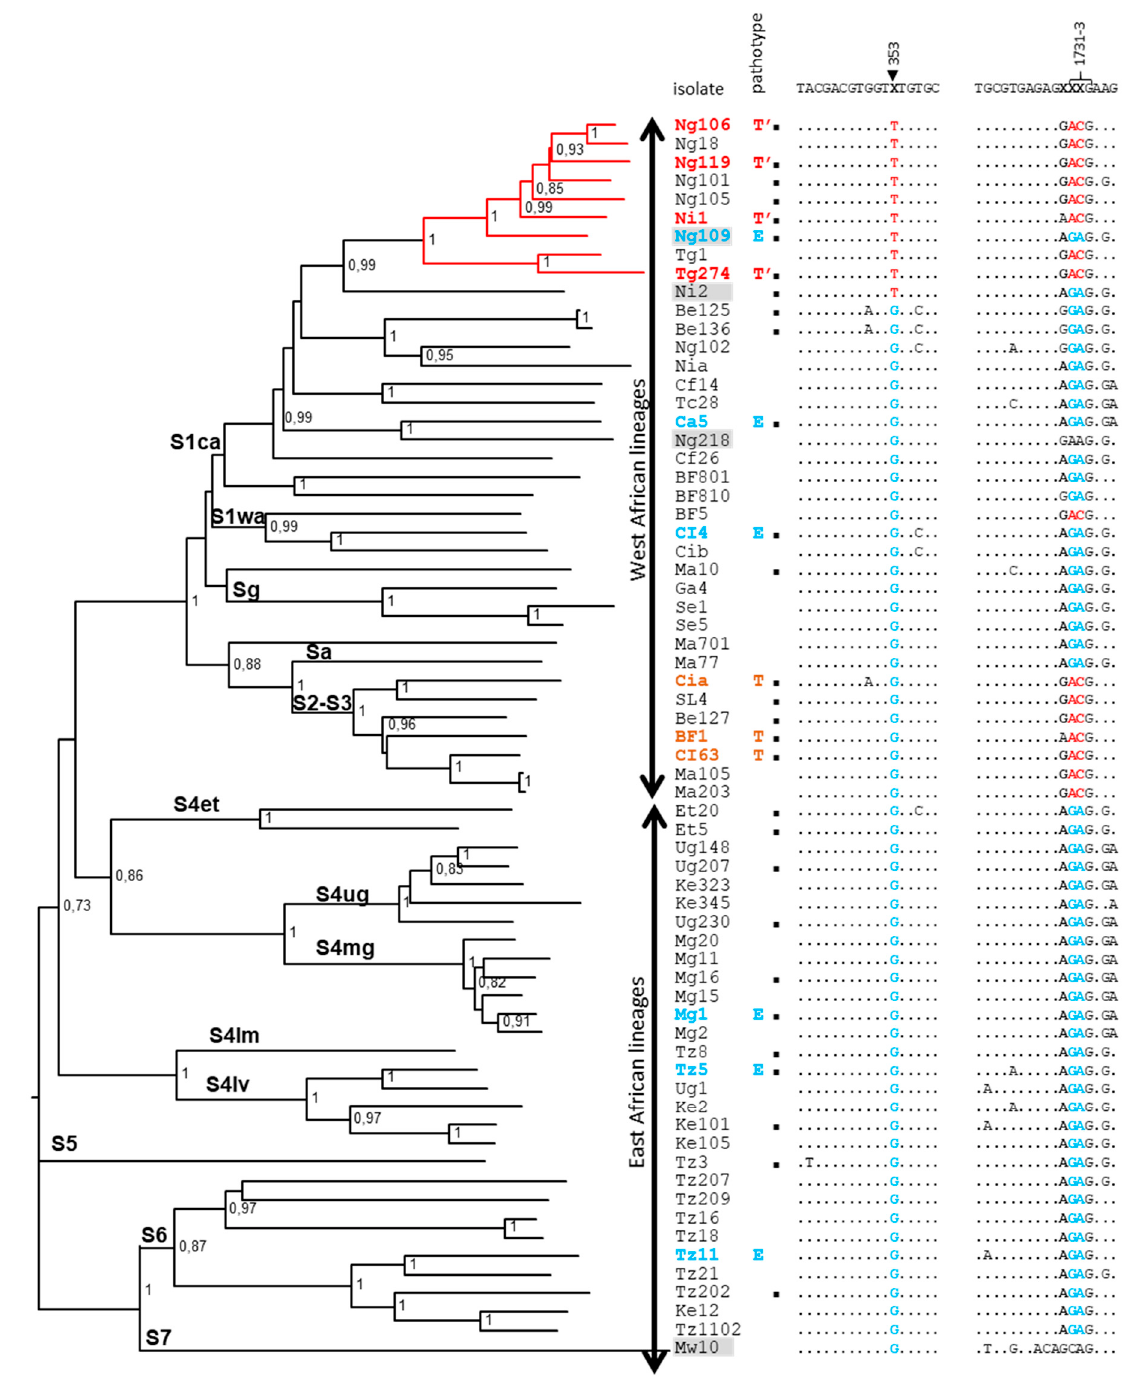
Figure 1. ( Left panel ) Phylogenetic tree of 67 genomic sequences representative of RYMV genetic diversity in Africa. Strains (S1–S7), lineages, and bootstraps were indicated on the tree. The lineage with T’ isolates is colored in red. Resistance-breaking ability is indicated by bolded isolate names (blue, orange, and red for pathotypes E, T, and T’, respectively). ( Right panel ), Partial alignments at polymorphic domains chosen to design specific primers. Specific polymorphic sites used for specific primers were highlighted in red or blue. Genomic numbering was indicated based on the reference isolate CIa. Fully sequenced isolates used to validate the molecular tools designed in this study are indicated by black squares. Isolates excluded from the sequence analysis were highlighted in